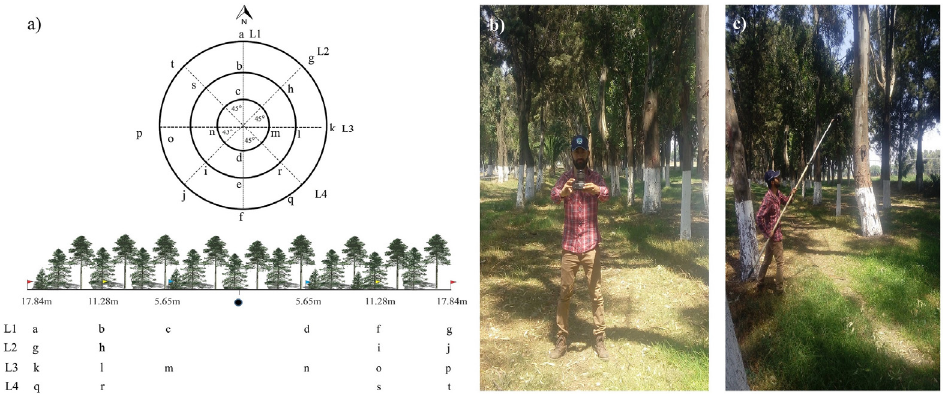
Figure 3. Photographic capture process at sampling sites. ( a ) CBSP design, the letters correspond to the distance of capture from the center of the sampling site; ( b ) photographic capture to zenith; ( c ) photographic capture to nadir.